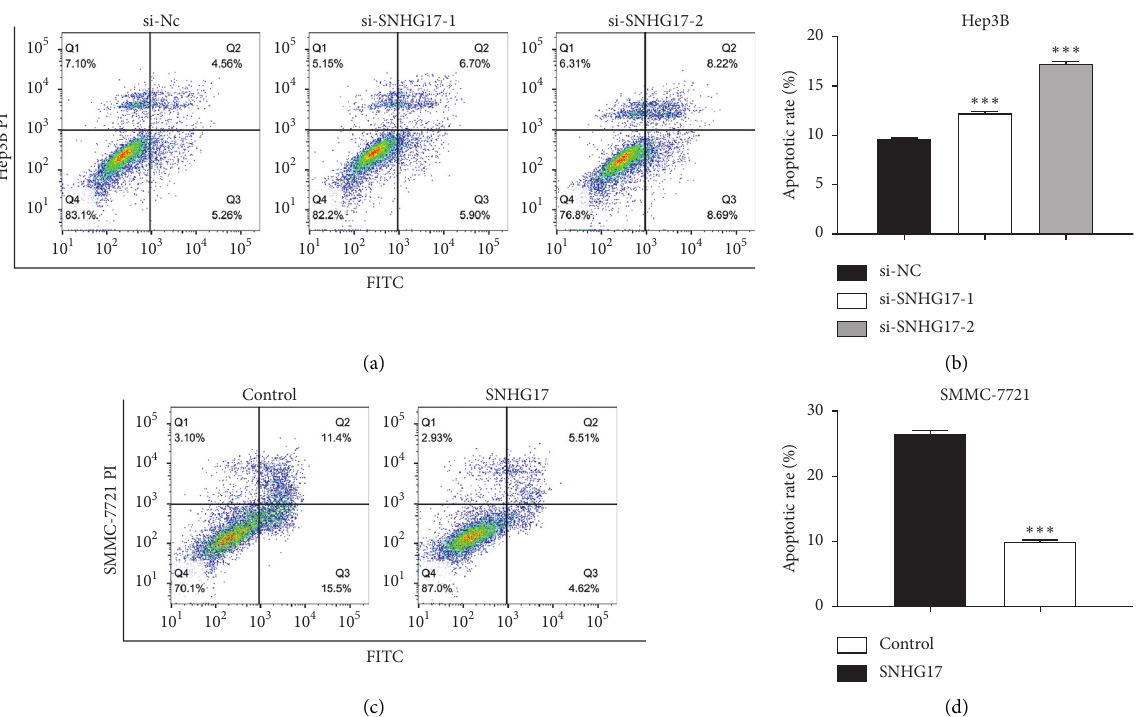
Figure 4: SNHG17 inhibited cell apoptosis of HCC. (a-b) Flow cytometry assays were employed to analyze the function of SNHG17 in apoptosis of Hep3B cells. (c-d) Flow cytometry assays were employed to analyze the function of SNHG17 in apoptosis of SMMC-7721. ∗∗∗ P < 0 .